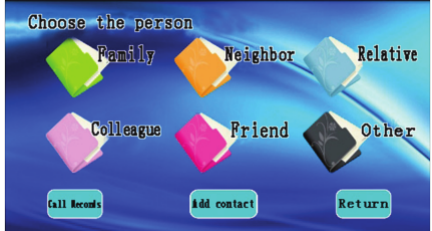
Figure 5: The initial interface page of the videophone.